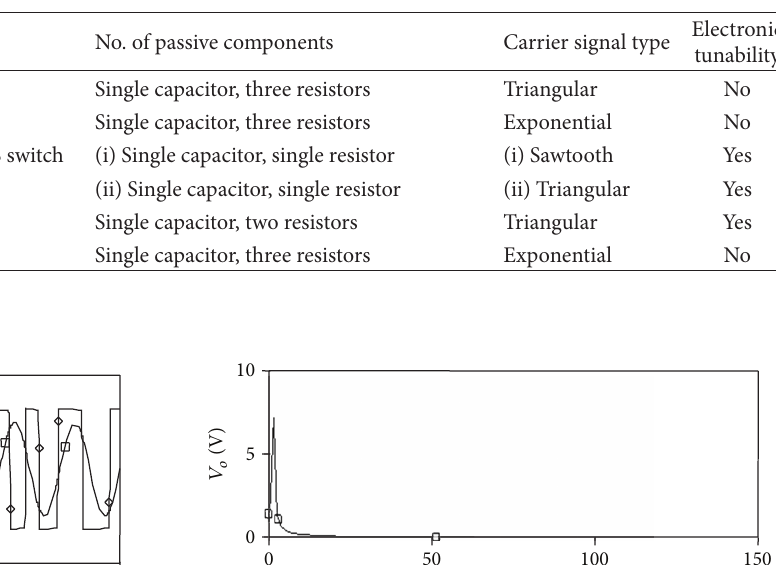
T 1: Comparison between the proposed and the previously reported works.